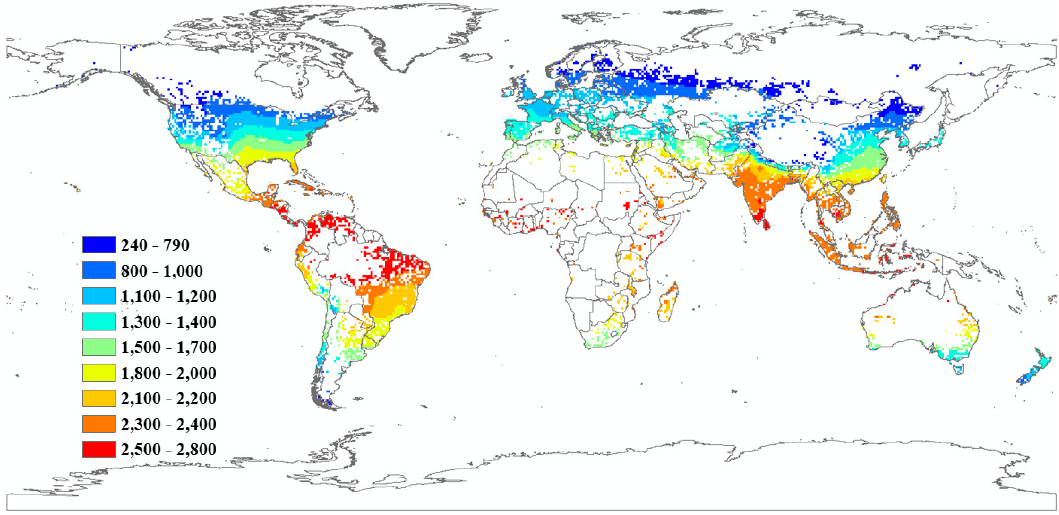
Figure 5. Net irrigation water requirement of ECHAM model in 2050 (RCP4.5). The same irrigated area than 1960 is used the same in Figure 1.